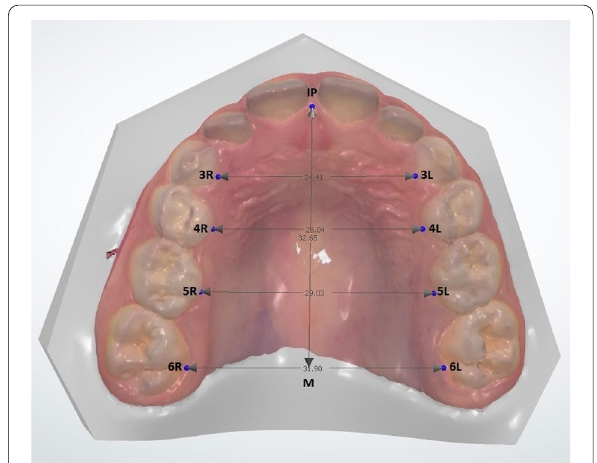
Fig. 2 The view of all measurements on a 3D digital model